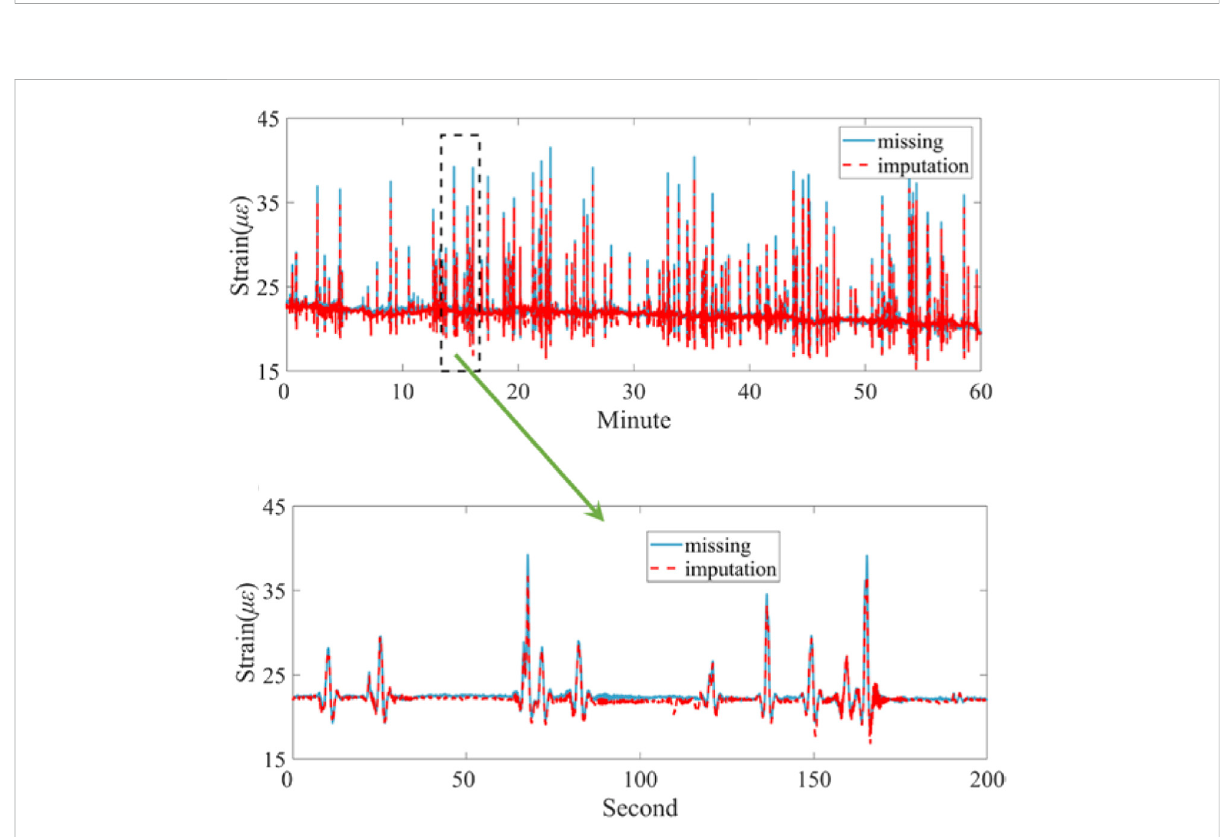
FIGURE 11 The completed strain data after reconstruction with GAN (Jiang et al.,